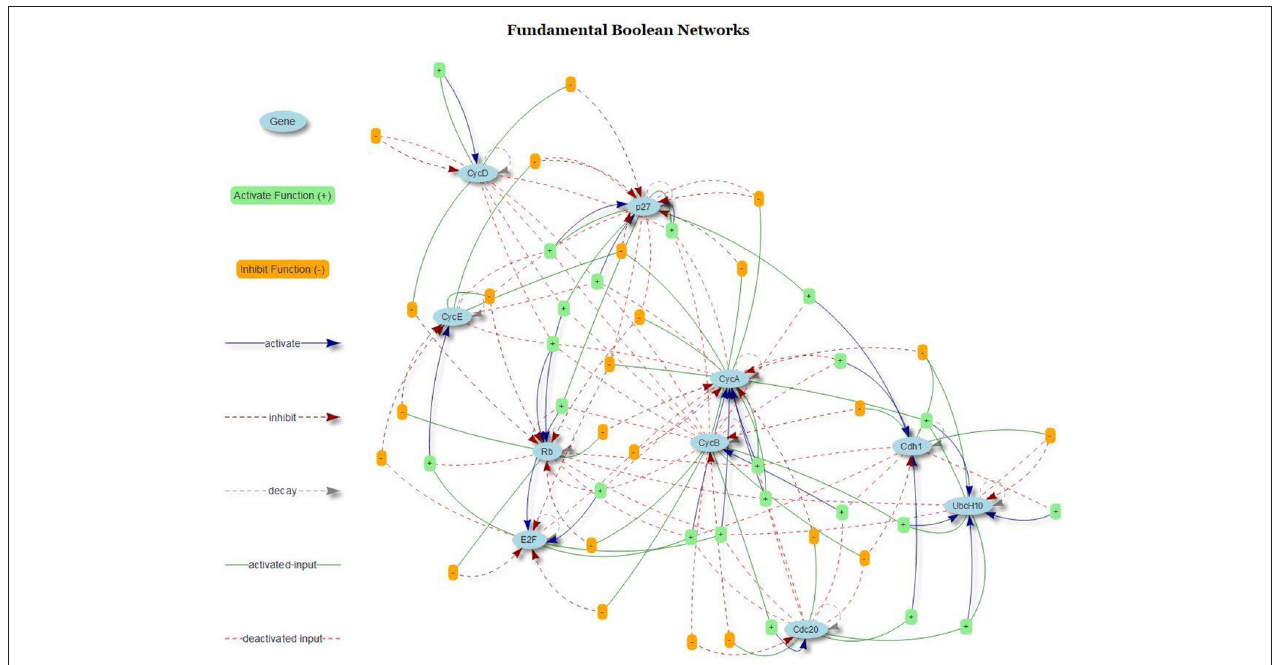
FIGURE 9 | Cell Cycle FBN. The light blue elliptical icons represent genes; the orange box icons represent inhibition functions, and the light green box icons represent activation functions. The dark blue arrows represent activation, dark red arrows represent inhibition, and gray arrows represent protein decay.